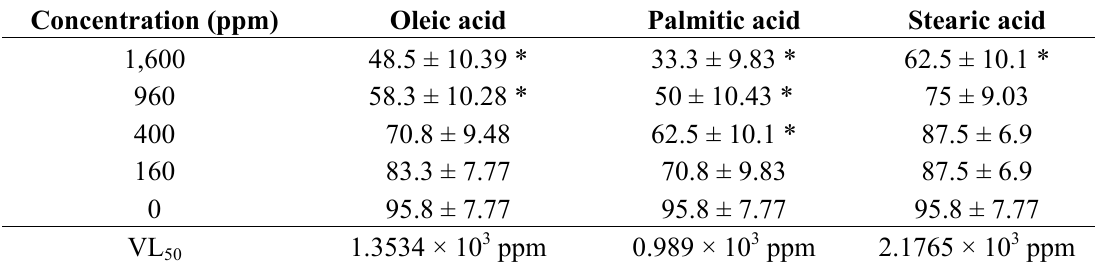
Table 3. Mean (±SE) larvae viability of S. frugiperda with oleic, palmitic and stearic acids. Concentration (ppm) Oleic